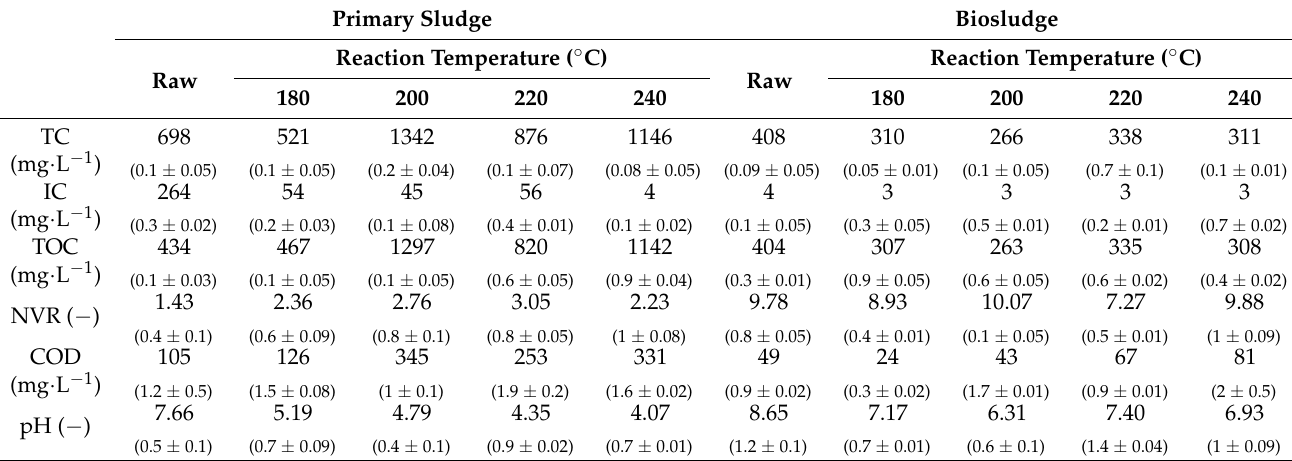
Table 2. Characterization of HTC